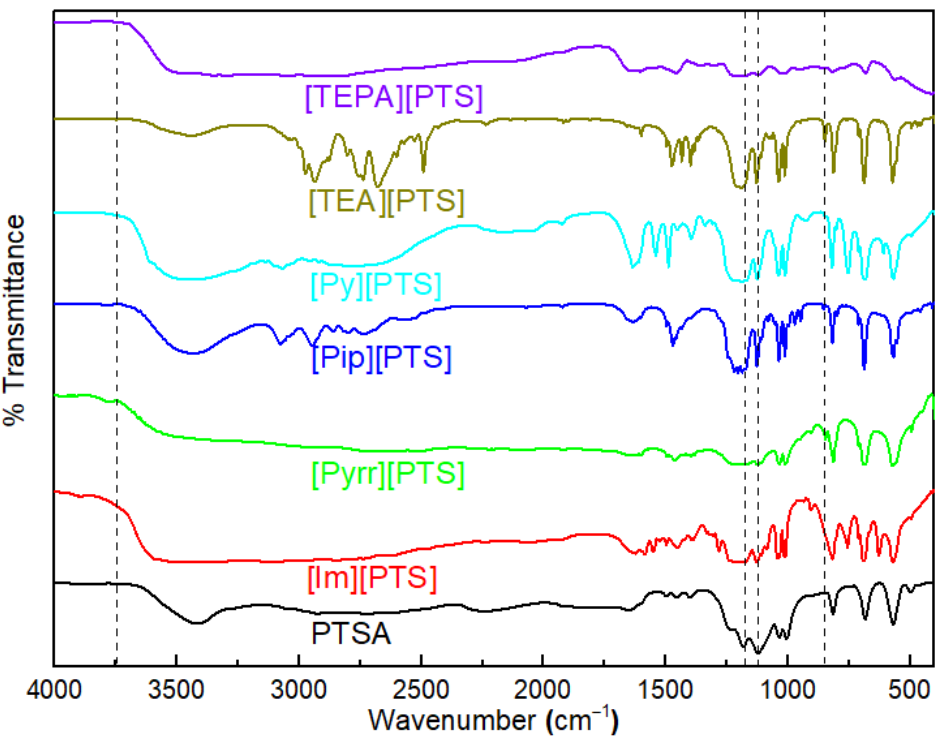
Figure 3. FTIR spectra of PTSA and the synthesized protic ionic liquids.